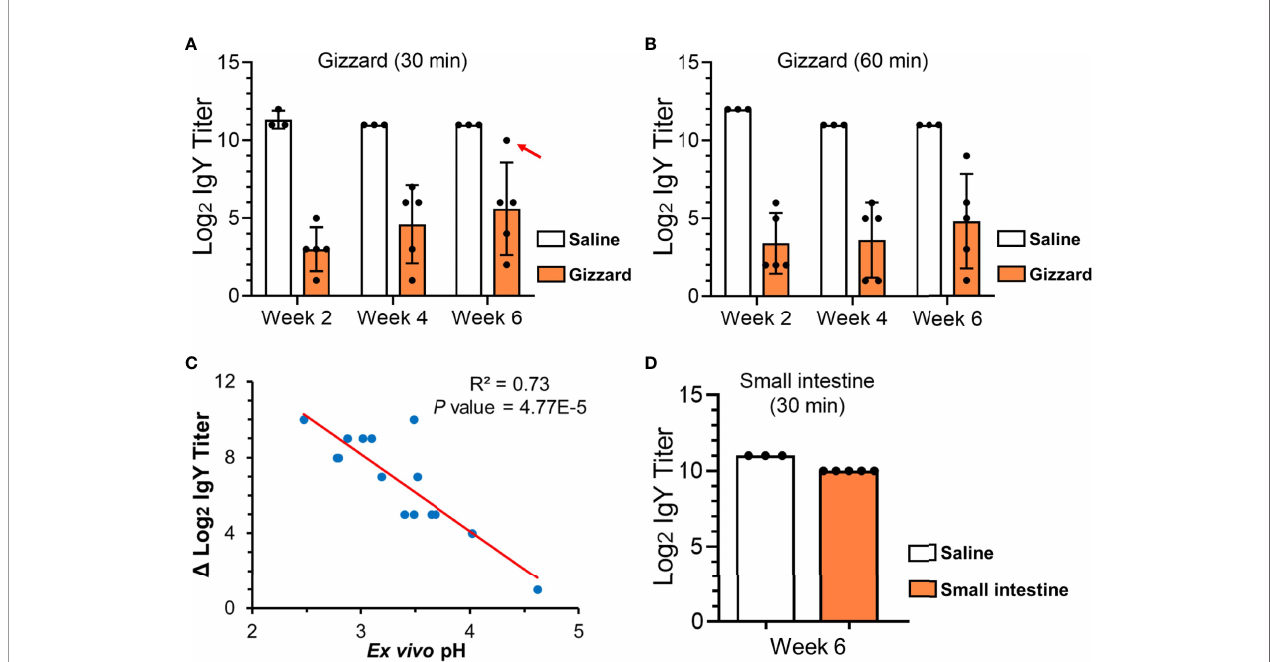
FIGURE 1 | ELISA titers of speci fi c egg yolk IgY in the GI samples collected from chickens at different ages. (A) Speci fi c egg yolk IgY titers upon treatment in saline (control) or gizzard contents collected at 2, 4, and 6 weeks of age at 42°C for 30 min. The dot indicated by a red arrow is an outlier sample with the highest ex vivo pH of 4.62. (B) Speci fi c egg yolk IgY titers upon treatment in saline (control) or gizzard contents at 2, 4, and 6 weeks of age at 42°C for 60 min. (C) Scatter plot showing an inverse correlation between ex vivo pH in the assays and the reduction of speci fi c IgY titer upon 30 min of treatment in gizzard content. The dots represent each of the 15 gizzard samples at different ages. P -value of 4.77E-5 indicates a signi fi cant linear correlation between the two variables. (D) Speci fi c egg yolk IgY titers upon treatment in saline (control) or small intestine contents at 6 weeks of age at 42°C for 30 min. In the bar plots above, data are presented as mean ± SD of measurements from fi ve chicken samples or three saline controls at each speci fi c time